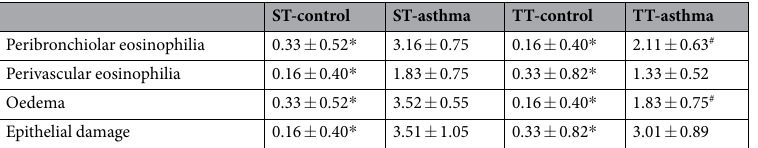
Table 1. Histopathological scoring of inflammatory change in the lungs of mice. Inflammatory changes were graded by histopathological assessment using a semiquantitative scale of 0–5 (Table 2). ST: standard temperature (20 °C); TT: thermoneutral temperature (30 °C). The data presented are mean ± SEM. * denotes P < 0.05 (ST-control vs. ST-asthma or TT-control vs.TT-asthma); # denotes P < 0.05 (TT-asthma vs. ST-asthma) (n = 6 mice per